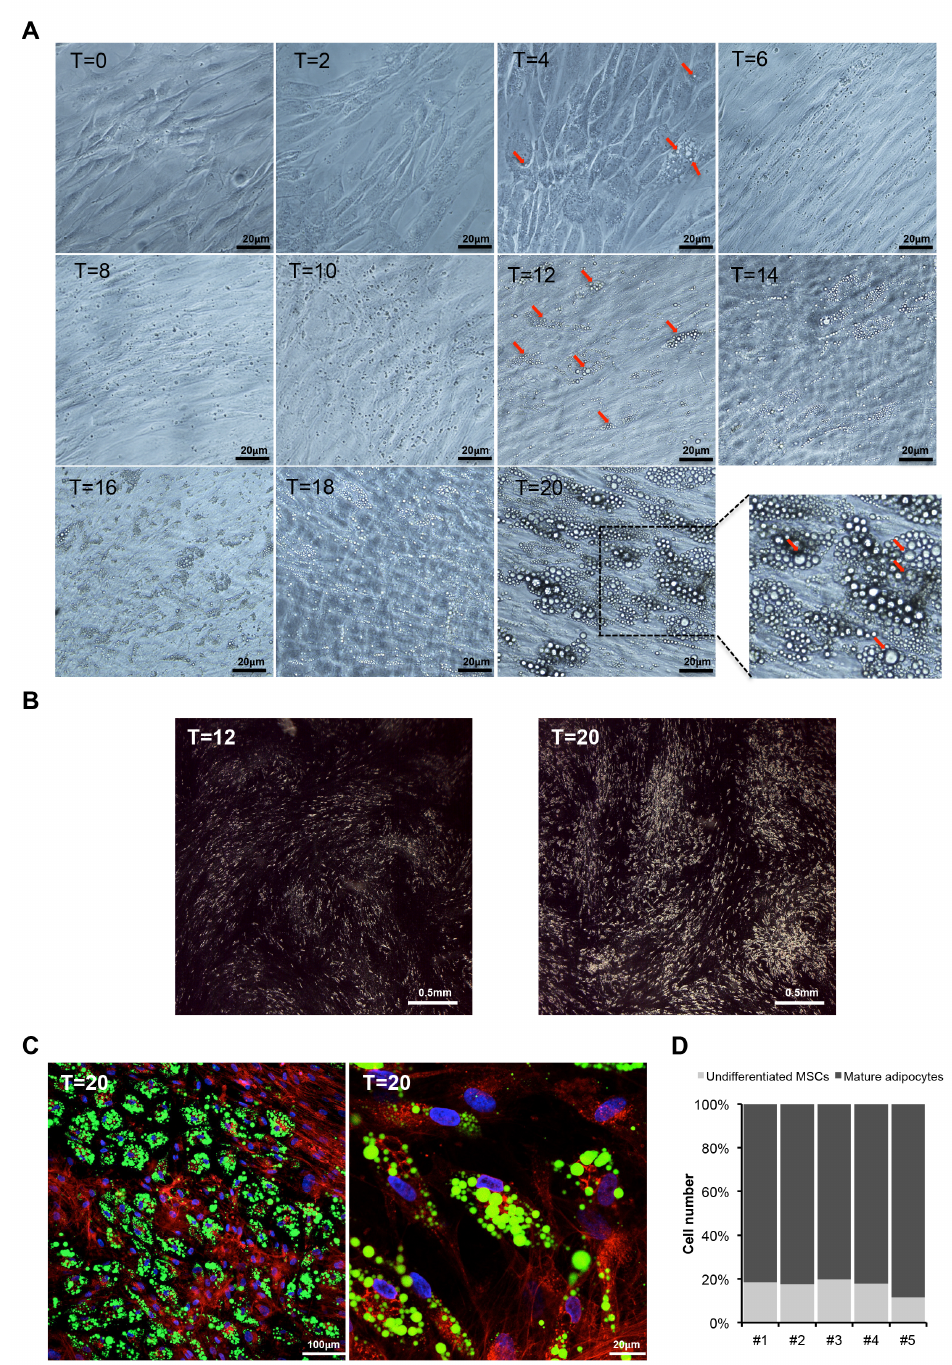
Figure 2. Human mesenchymal stem cells (hMSCs) are a reliable in vitro model of human adipocyte differentiation. ( A ) Representative phase-contrast images showing morphological changes of hMSCs along adipocyte differentiation, i.e., at starting point (T = 0 h), at different time points upon adipogenesis induction (T = 2, 4, 6, 8, 10, 12, 14, 16, 18 days) and at terminal differentiation (T = 20 days). Red arrows indicate some lipid droplets visible by optical microscopy during adipocyte differentiation (scale bar, 20 µ m). ( B ) Representative images of hMSCs at 12 days and 20 days upon induction fixed with osmium tetraoxide and observed in dark field microscopy. The LDs are showed as white dots (scale bar, 1 mm). ( C ) Representative confocal microscopy images of hMSCs differentiated in mature adipocytes (T = 20